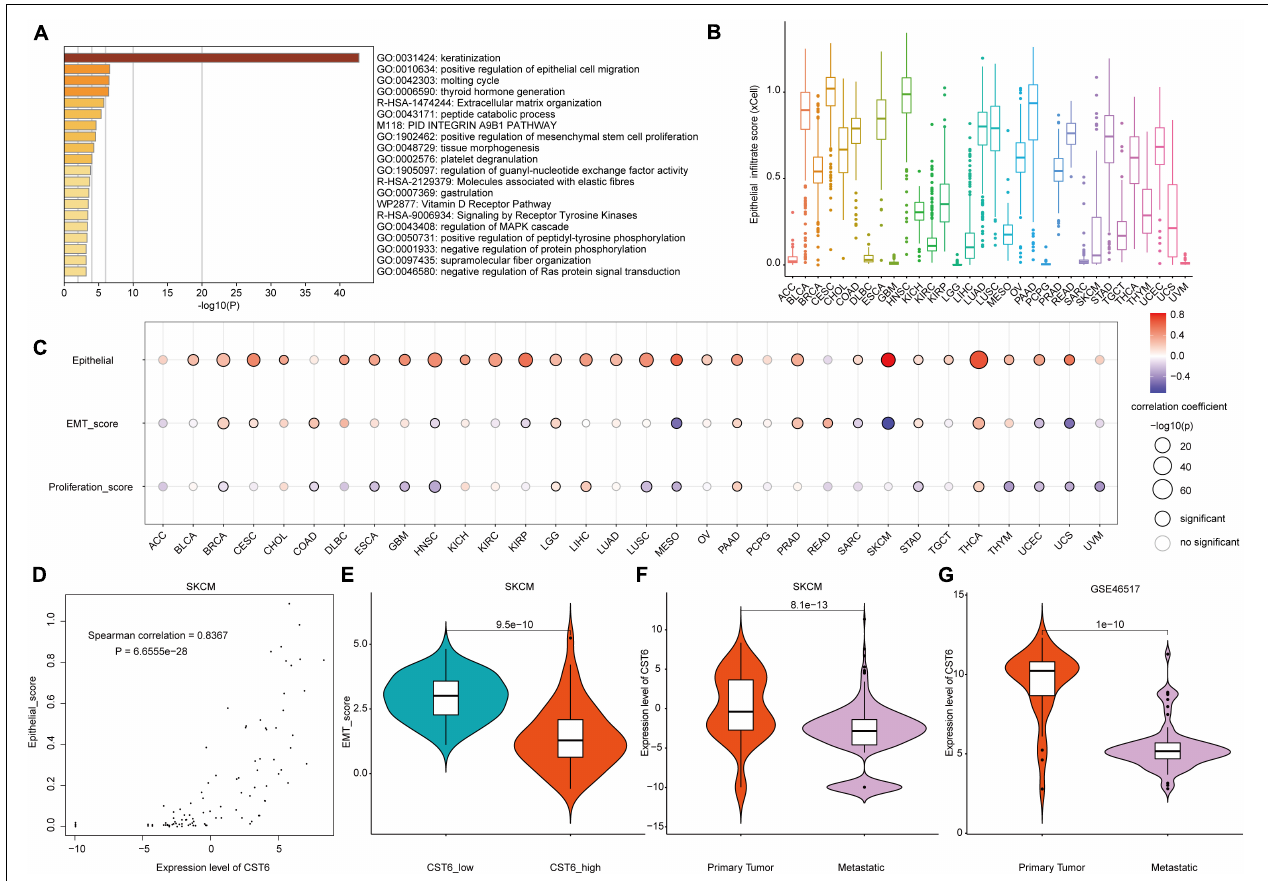
FIGURE 4 | The functional analysis of CST6. (A) The functional enrichment analysis based on the top 500 CST6-related genes through Metascape. (B) The distribution of epithelial infiltrate score obtained from xCell across TCGA cancer types. (C) The Spearman correlation between the expression of CST6 and epithelial cell infiltration, epithelial-to-mesenchymal transition (EMT) score, and proliferation. (D) The correlation between the expression of CST6 and the epithelial cell infiltrate score for SKCM in TCGA. (E) The violin plot of EMT score between CST6-low and CST6-high groups for SKCM in TCGA. (F,G) The violin plot of expression level of CST6 between primary tumor and metastatic samples for SKCM in TCGA and external validation dataset.